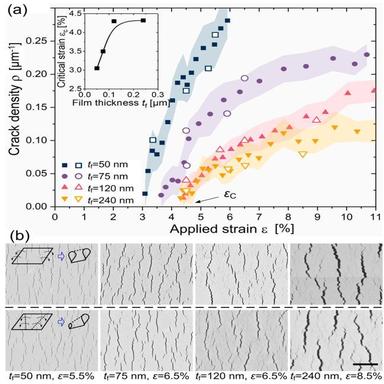
a) Experimental results of crack density ρ as functions of applied strain ε for Cu film with different thicknesses tf on PEN by asymmetrical (solid symbols) and typical bending strategies (open symbols). The critical strain, εc, defined as the strain for crack initiation, can be estimated by extrapolating the ρ-ε data back to ρ=0. The inset shows εc as a function of tf. b) Comparison of crack patterns by the typical (upper panel) and the asymmetrical (lower panel) strategies for different film thicknesses